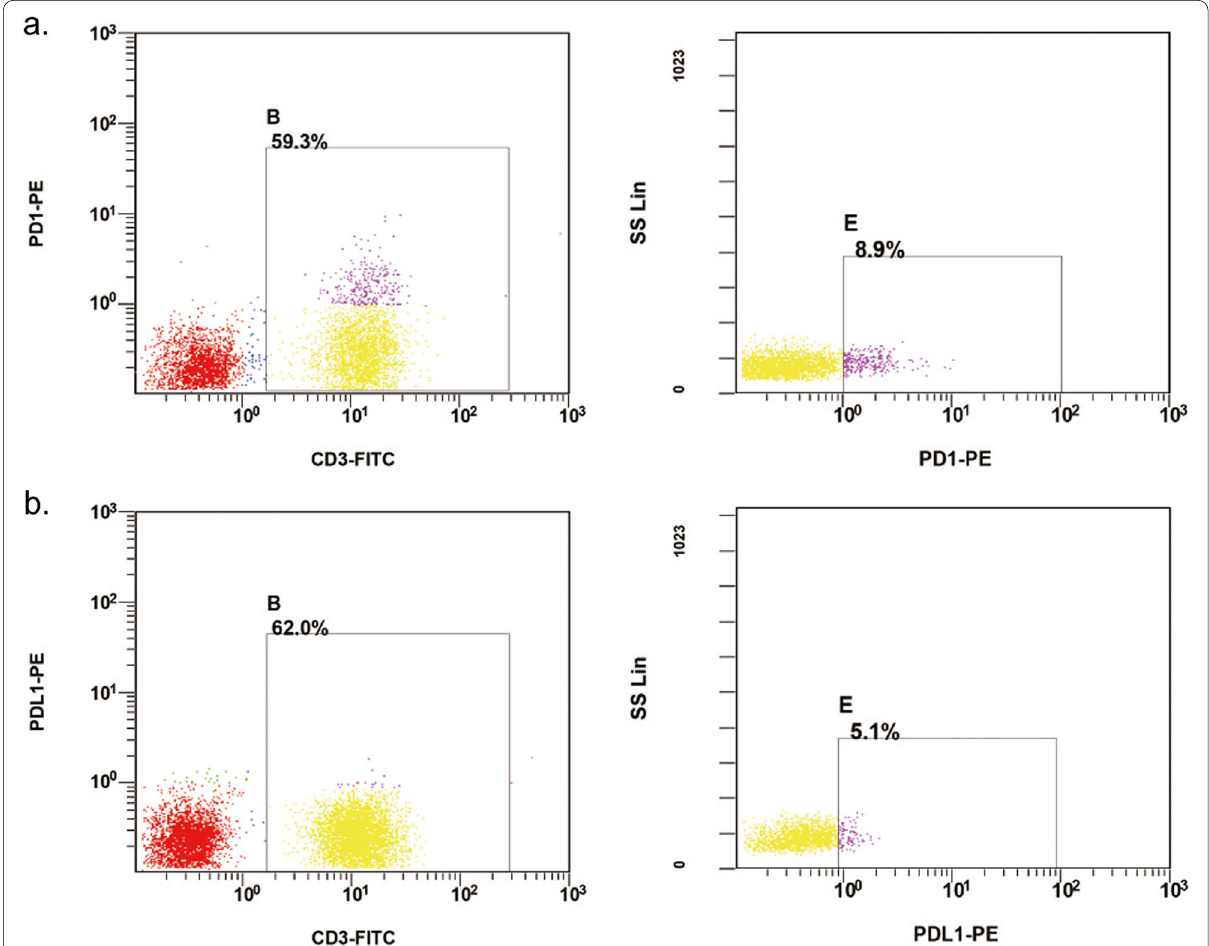
Fig. 1 The expression of PD-1/PD-L1 on circulating T